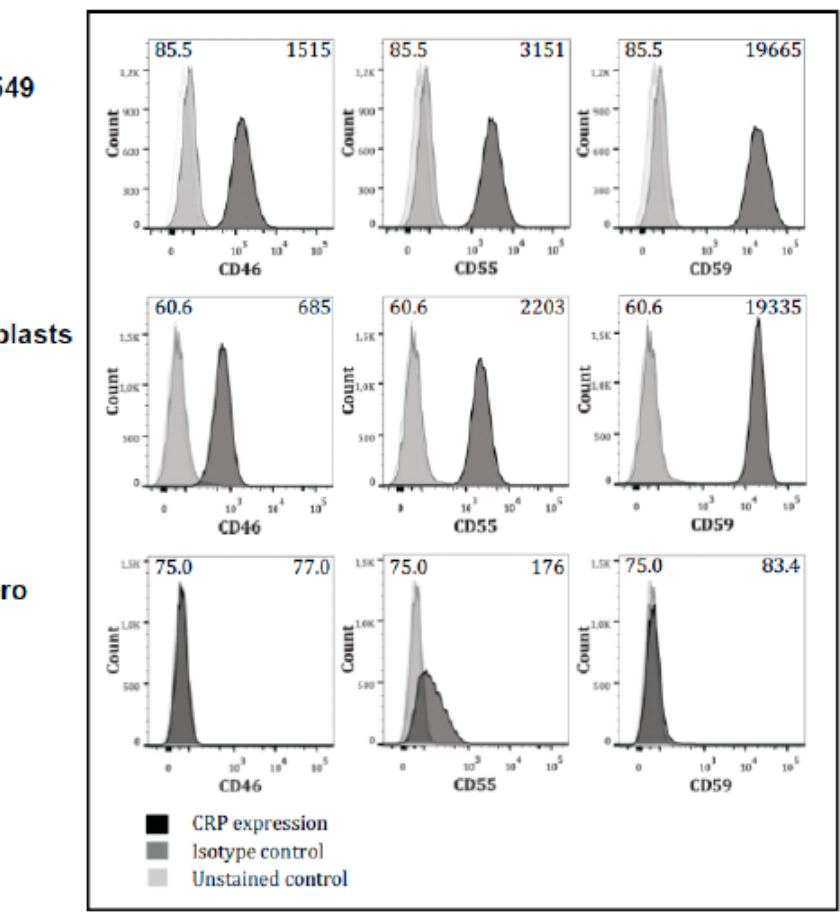
Figure 3. FACS analyses on A549, fibroblasts, and Vero cells for the expression of CD55, CD59, and CD46. Detection of membrane-anchored complement regulator protein (mCRP) expression on ZIKV-producing cells by FACS analysis. Cells were stained with anti-human CD46, CD55, or CD59 (dark grey histogram) or isotype-matched Ab (light gray